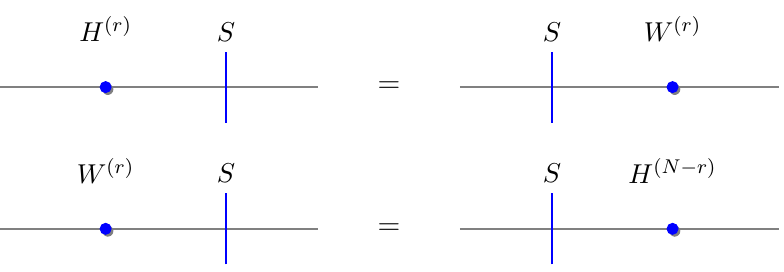
Figure 14 . Under S duality, a Wilson loop becomes an ’t Hooft